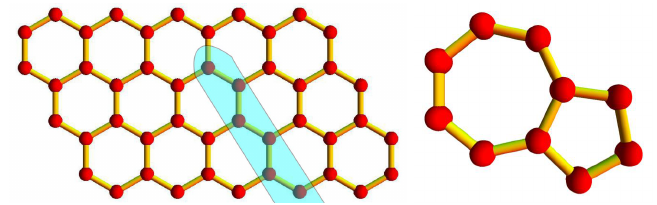
Figure 1. Edge dislocation appearing as a pentagon-heptagon pair in the perfect lattice of a graphene